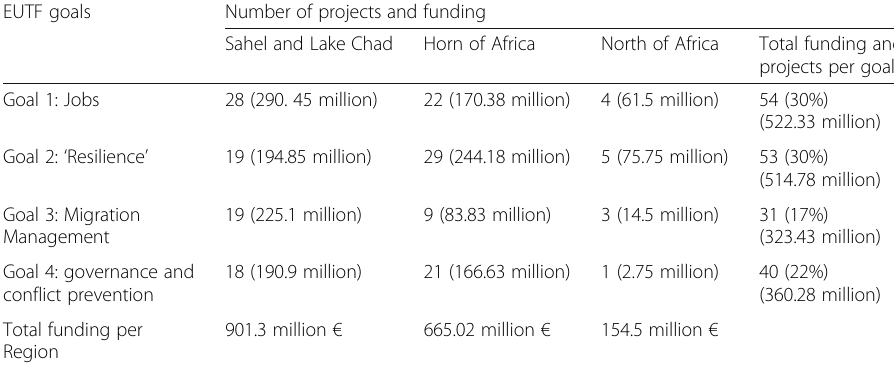
Table 4 An overview of the EUTF according to region and goals EUTF goals Number of projects and funding Sahel and Lake Chad Horn of